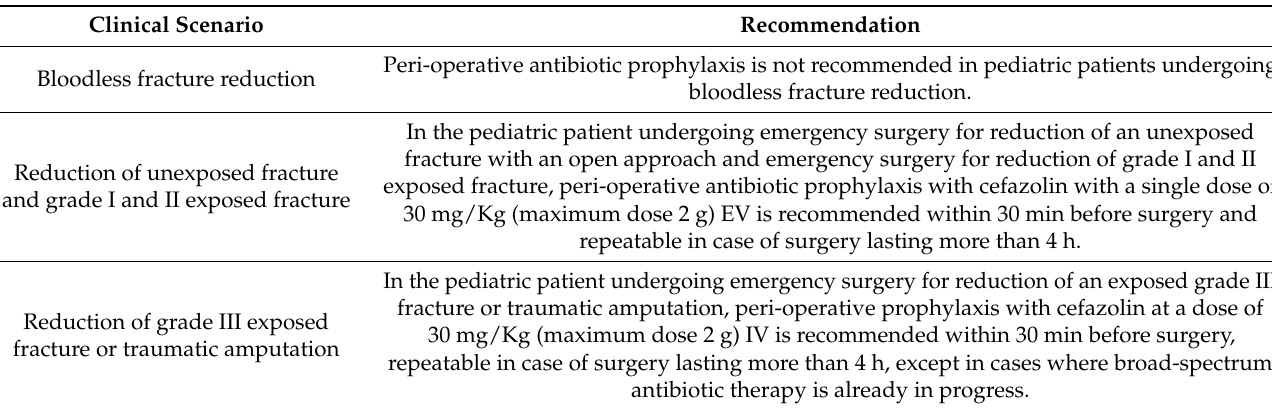
Table 2. Surgical antimicrobial prophylaxis for patients of neonatal and pediatric age undergoing orthopedic and hand